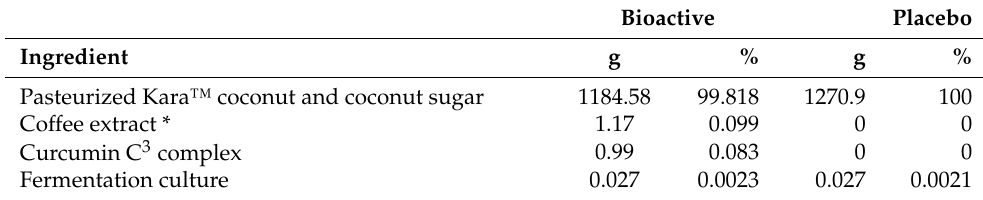
Table 2. Formulation of coconut cream yoghurt with added